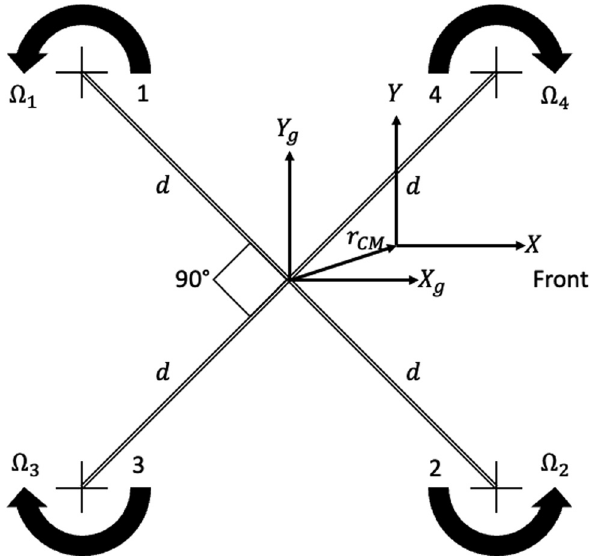
Figure 3: Quadcopter top